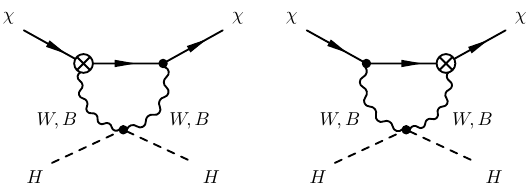
and Q 0 (5) into the Higgs 1 2